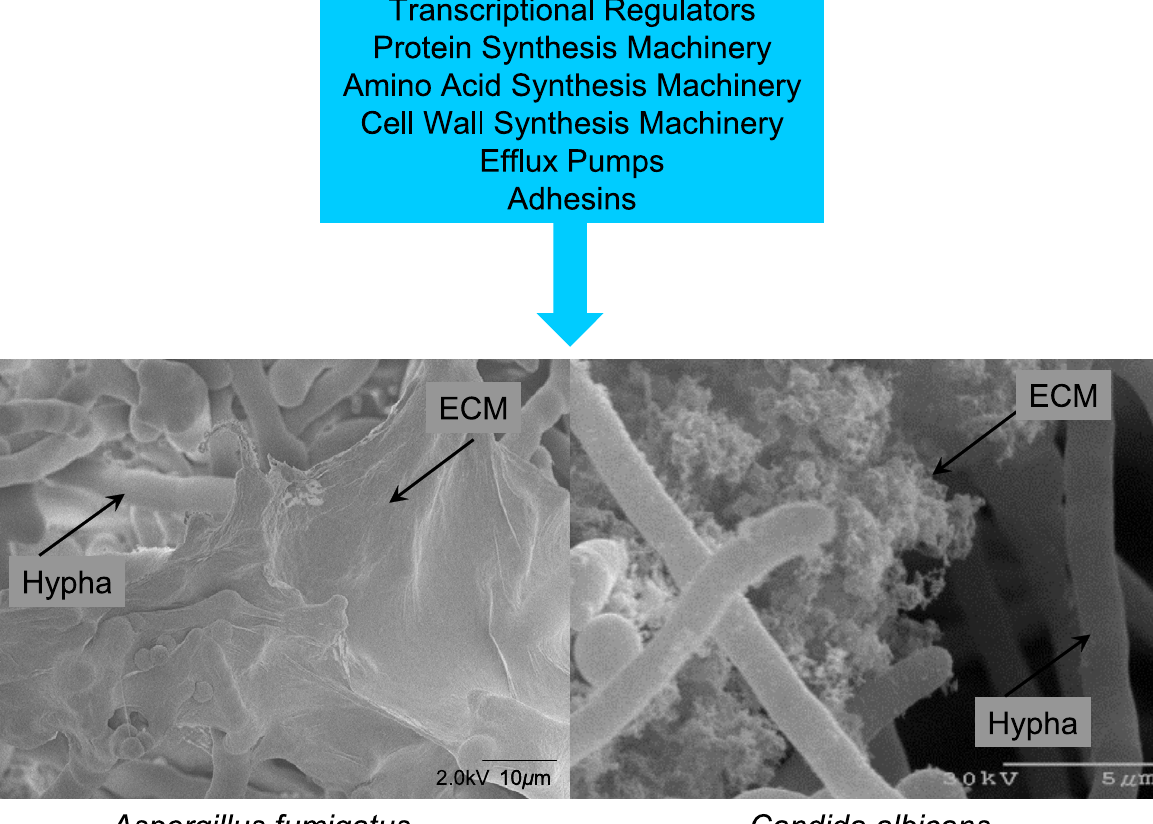
Figure 1. Common features of fungal biofilms. Gene expression has been compared between planktonic cells and biofilm cells of both A. fumigatus and C. albicans . The major functional categories of genes upregulated in biofilms are summarized in the blue box. The micrographs below show a cryo SEM view of an A. fumigatus biofilm (left; Stephanie Guadagnini, Anne Beauvais, and J.P. Latge, Institut Pasteur, Paris, France) and a scanning EM view of C. albicans in vitro biofilm cells (right; Fanning, Suhan, and Mitchell, unpublished). In both cases, extracellular matrix (ECM) is evident.